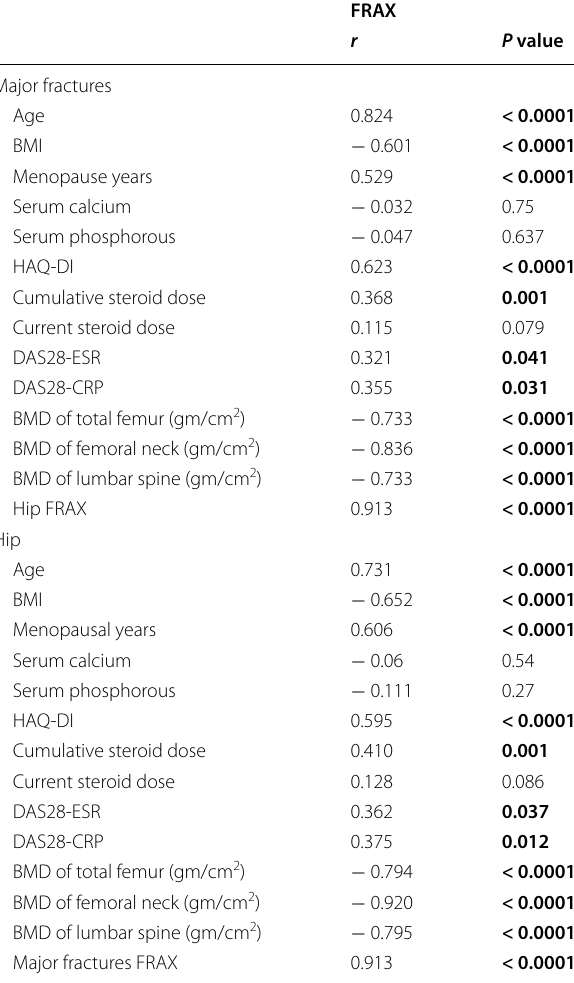
Table 3 Spearman’s correlation of hip and major fractures FRAX with other variables in the studied subjects in the RA